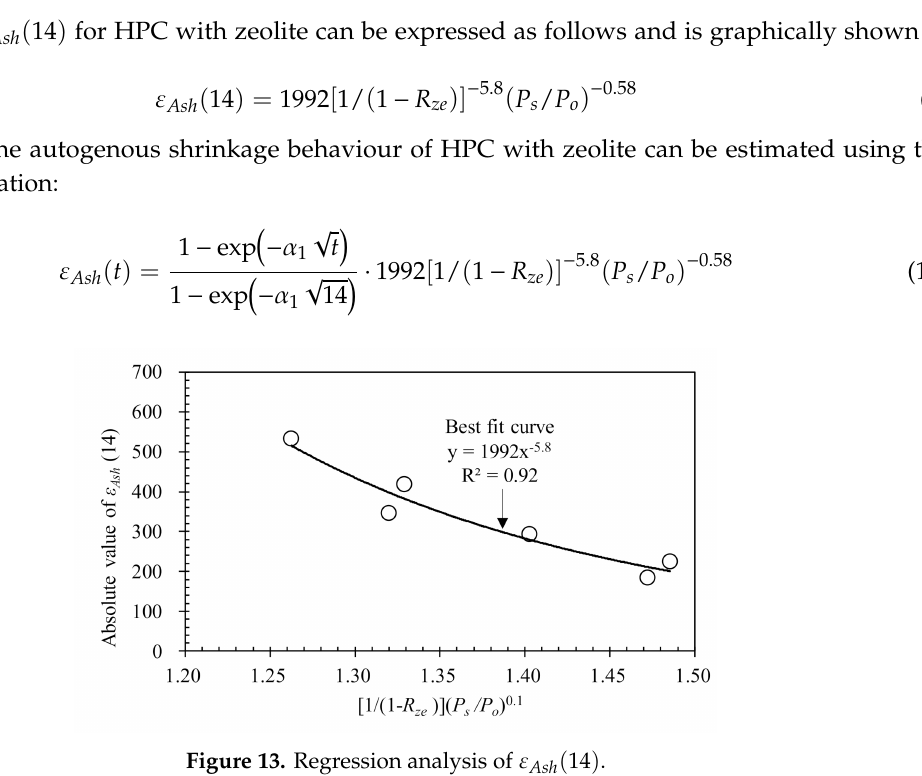
Figure 13. Regression analysis of ε Ash ( 14 )